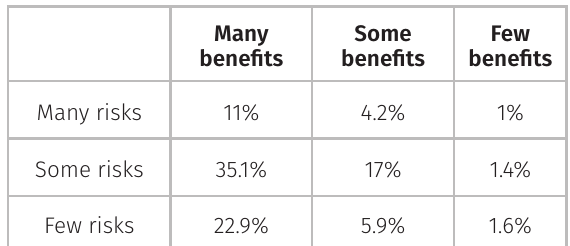
Table II. Bivariate table: Benefits versus risks of S&T. Ordinal by ordinal association significant with gamma = -0.124,